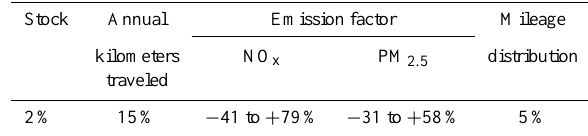
Table 3. Uncertainty scales of